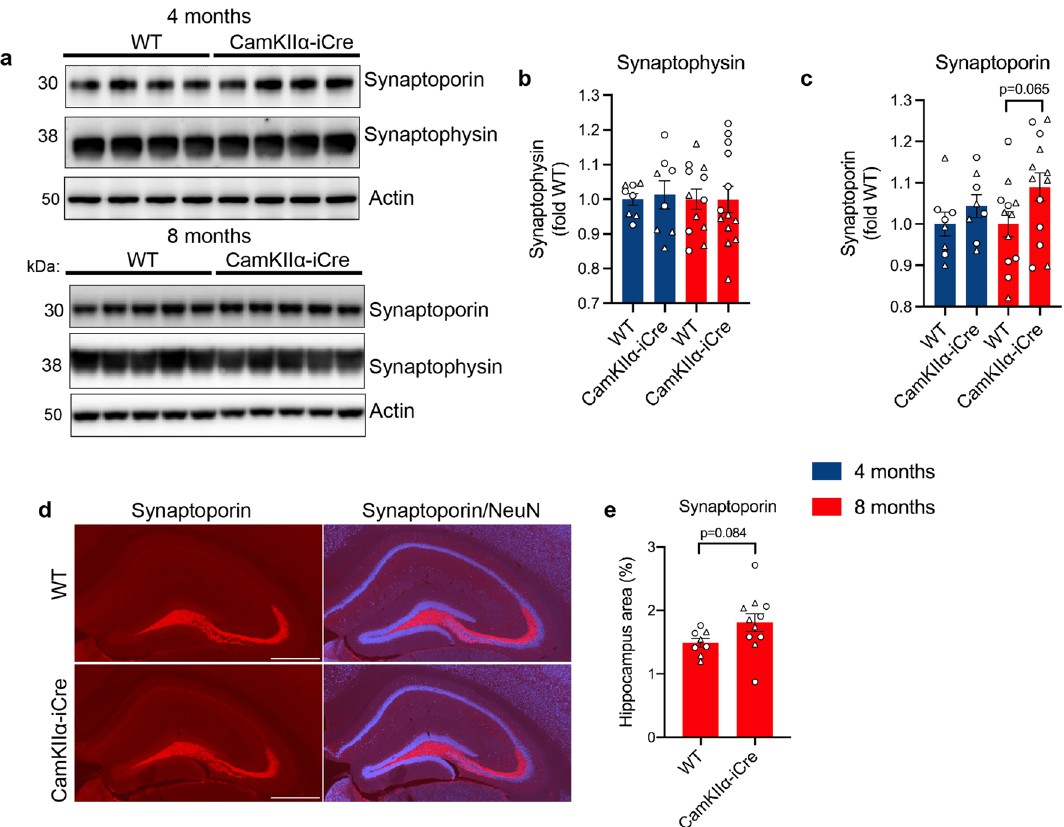
Figure 4. Presynaptic proteins are unchanged in the hippocampus of CaMKIIα-iCre mice. (A) Immunoblot of hippocampal homogenates from 4-month-old and 8-month-old male WT and CaMKIIα-iCre mice probed for synaptophysin, synaptoporin and actin. Original immunoblots are shown in Fig. S5A,B. Quantification of synaptophysin (B) and synaptoporin (C) immunoblots in (A) normalized to actin and expressed as fold of WT (WT, n = 12; CaMKIIα-iCre, n = 13). Circles = females, triangles = males. (D) Immunofluorescence microscopy of representative coronal brain sections showing the hippocampus from 8-month-old male WT and CaMKIIα-iCre mice labeled for synaptoporin (red) and NeuN (blue). Scale bar, 1000 µm. (E) Quantification of synaptoporin immunostaining as a percentage of area covering the hippocampus from WT and CaMKIIα-iCre mice (WT, n = 9; CaMKIIα-iCre, n = 11). Unpaired t-test was performed for all quantifications and values are mean ±